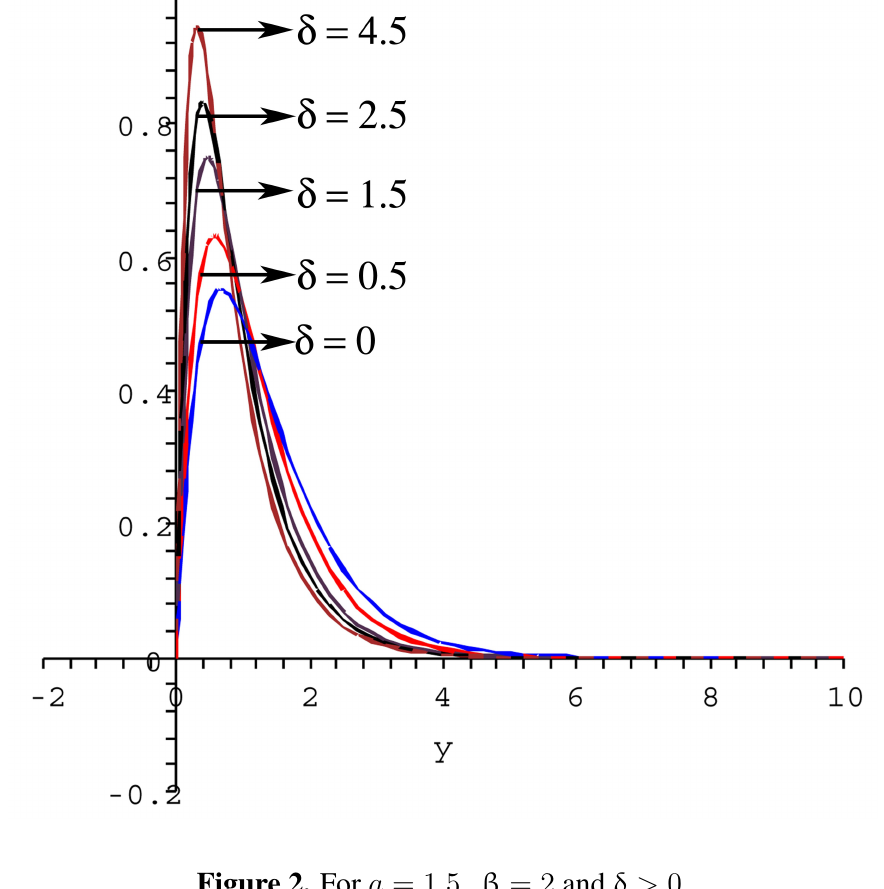
Figure 2. For a = 1 . 5 , β = 2 and δ > 0